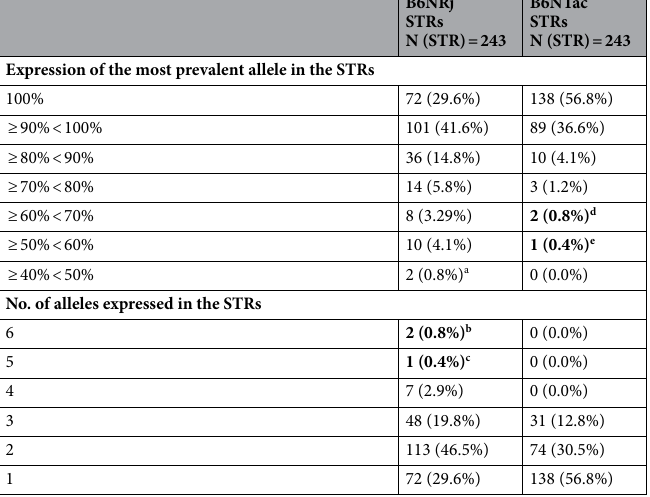
Expression of the most prevalent allele in the